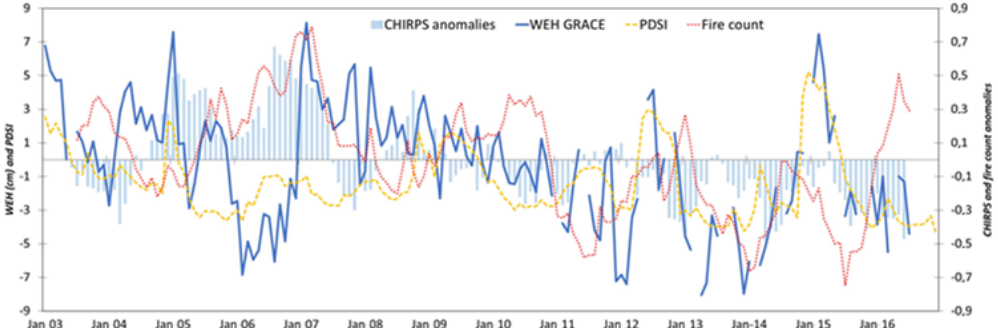
Figure 3. Covariations at Boeny Region scale between January 2003 and December 2016 of rainfall anomalies (CHIRPS data, reduced centred values), Water Equivalent Height (WEH, in cm; GRACE Mascon data), PDSI (Palmer Drought Severity Index; TerraClimate data) and regional fire count (Global Fire Emissions Database